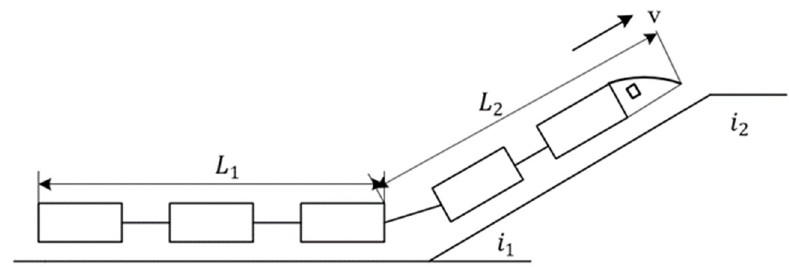
Figure 1. Schematic diagram of the ramp resistance of a multi-mass model maglev train. The formula for the unit tunnel resistance of a maglev train is as follows [16]: